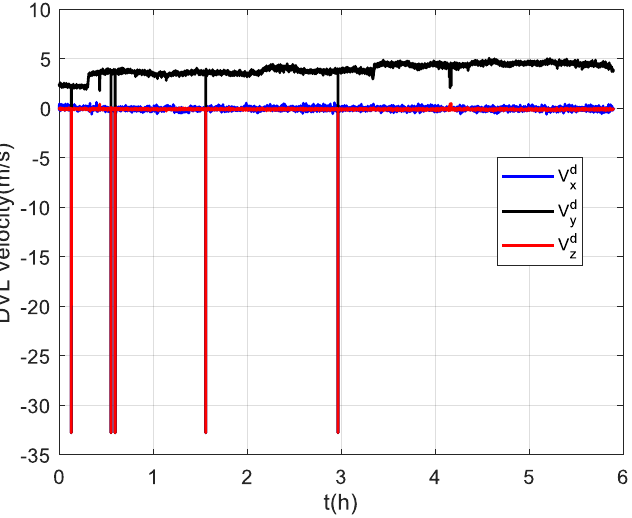
Figure 5. The velocity outputs of the DVL.